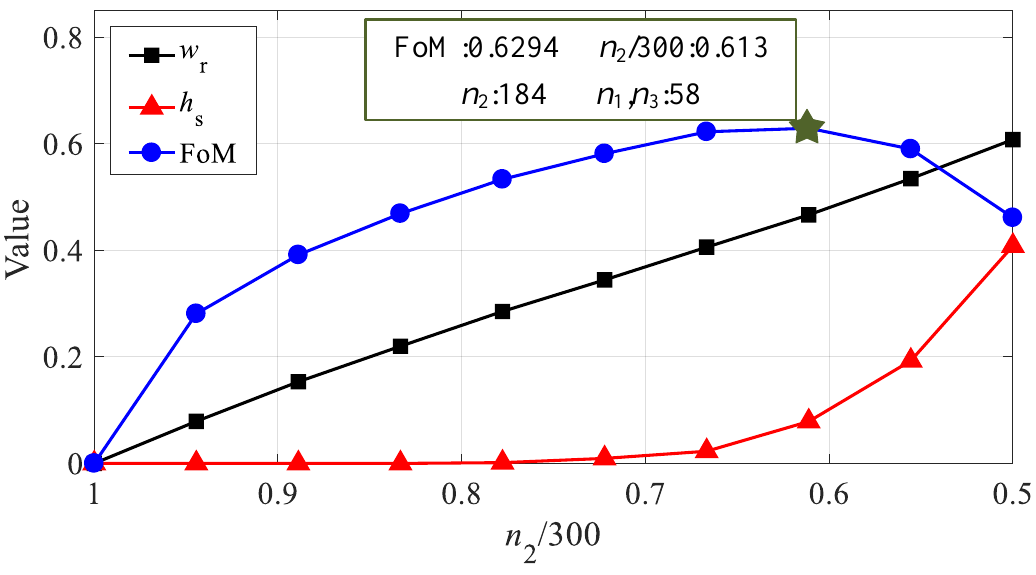
Figure 4. MF performance of the proposed STC with different winding parameters.